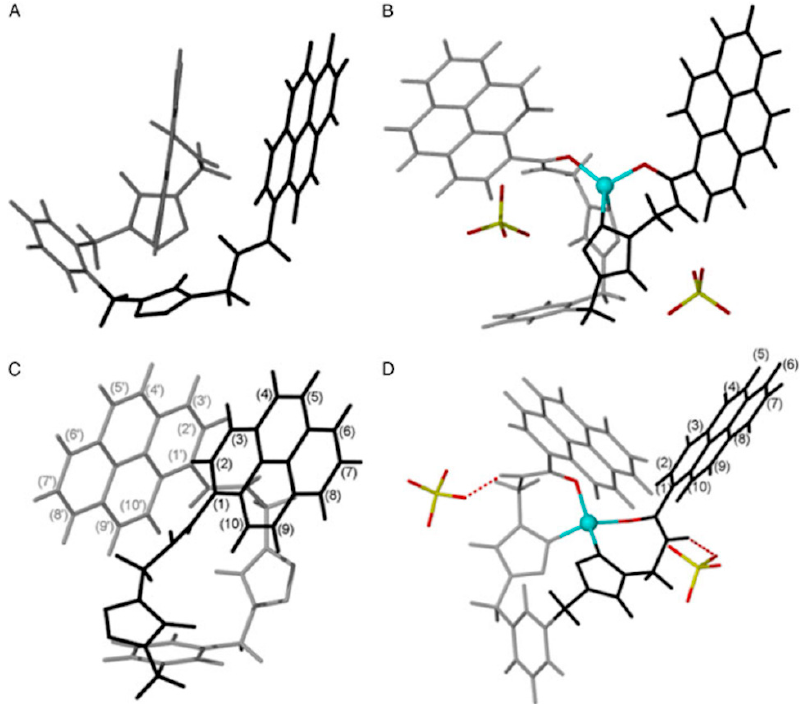
Figure 6. Fully optimized structures (DFT) in the gas phase of ( A ) compound 18a , ( B ) [Zn · 18a ](ClO 4 ) 2 , ( C ) compound 18b , and ( D ) [Zn · 18b ](ClO 4 ) 2 . Adapted From [163], with permissiom from Taylor & Francis Ltd.